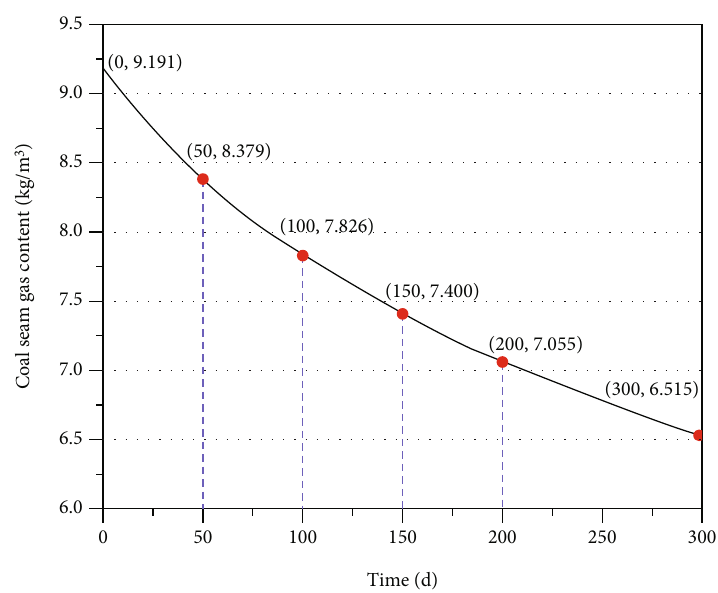
Figure 4: Average gas content of combined coal seams with di ff erent extraction times.